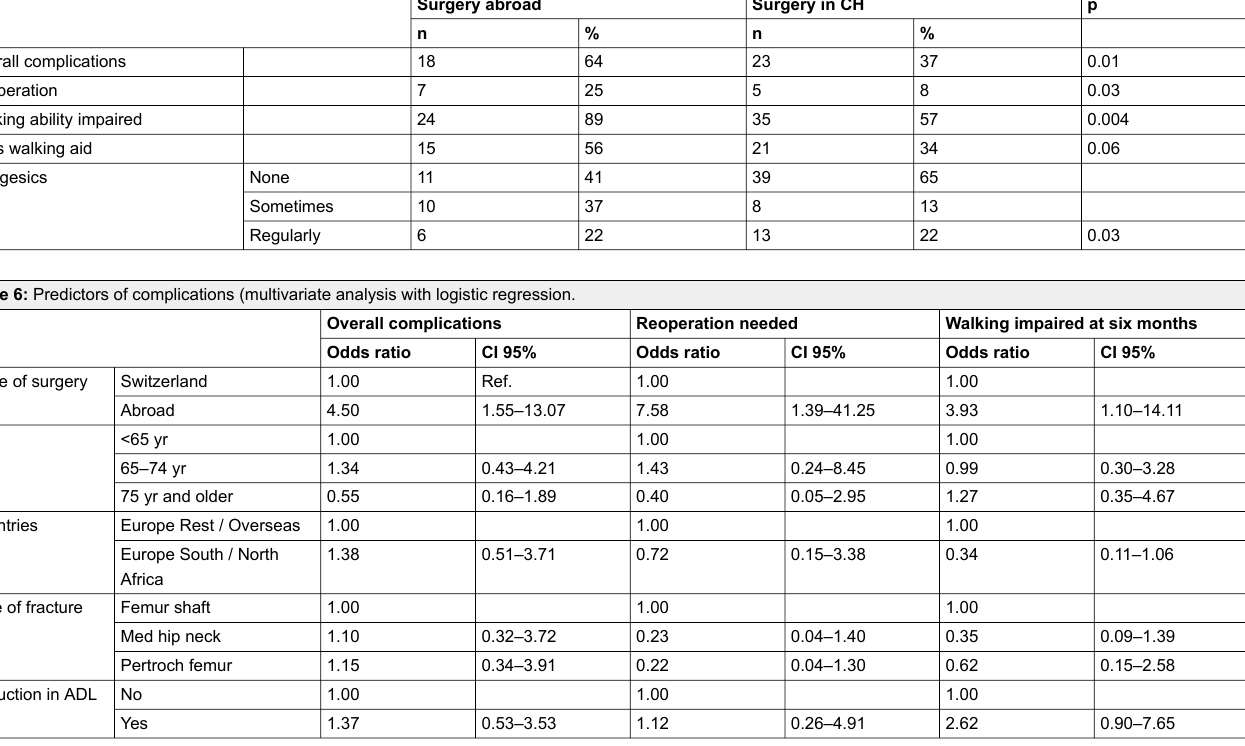
Surgery abroad Surgery in CH